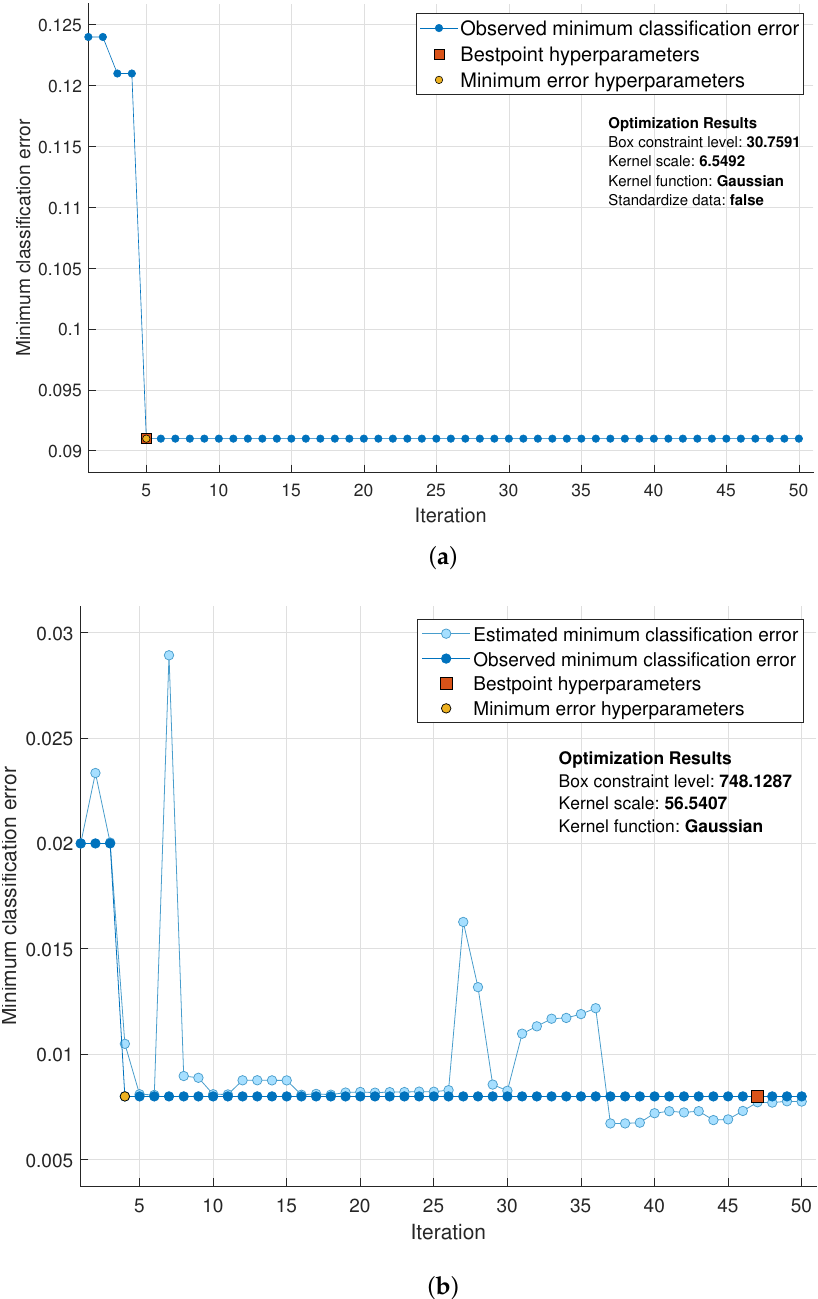
Figure 4. Minimum classification error plot of the optimized SVM classifier for the pneumonia diagnosis system using Bayesian optimization vs. random search optimization. ( a ) Random search optimization, and ( b ) Bayesian